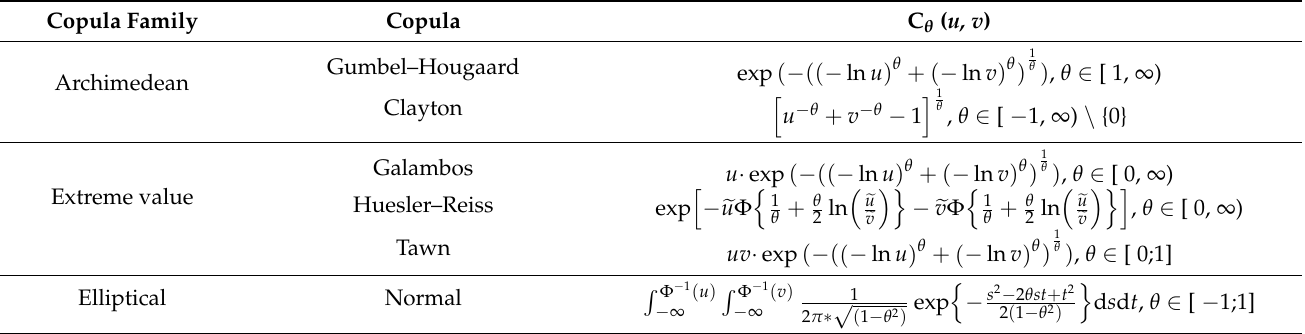
Table 3. Properties of the applied copula functions [16,87]. Copula Family Copula C θ ( u, v